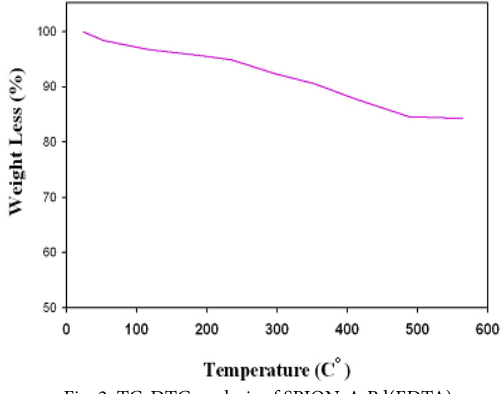
Fig. 2: TG-DTG analysis of